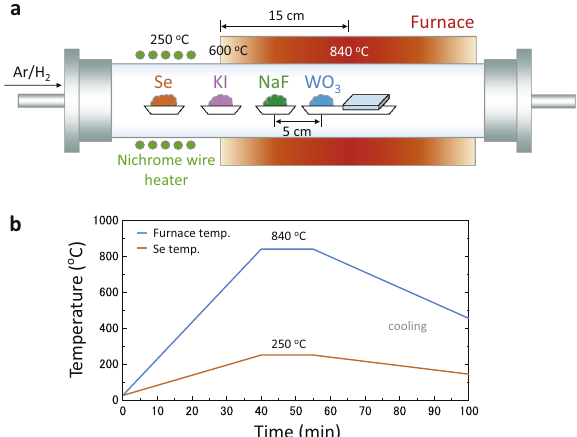
Fig. 1 CVD growth of 2D IF layer on WSe 2 . a Schematic of the WSe 2 growth with adding KI and NaF as the growth promoter. b Temperature – time plot of the WSe 2 growth.